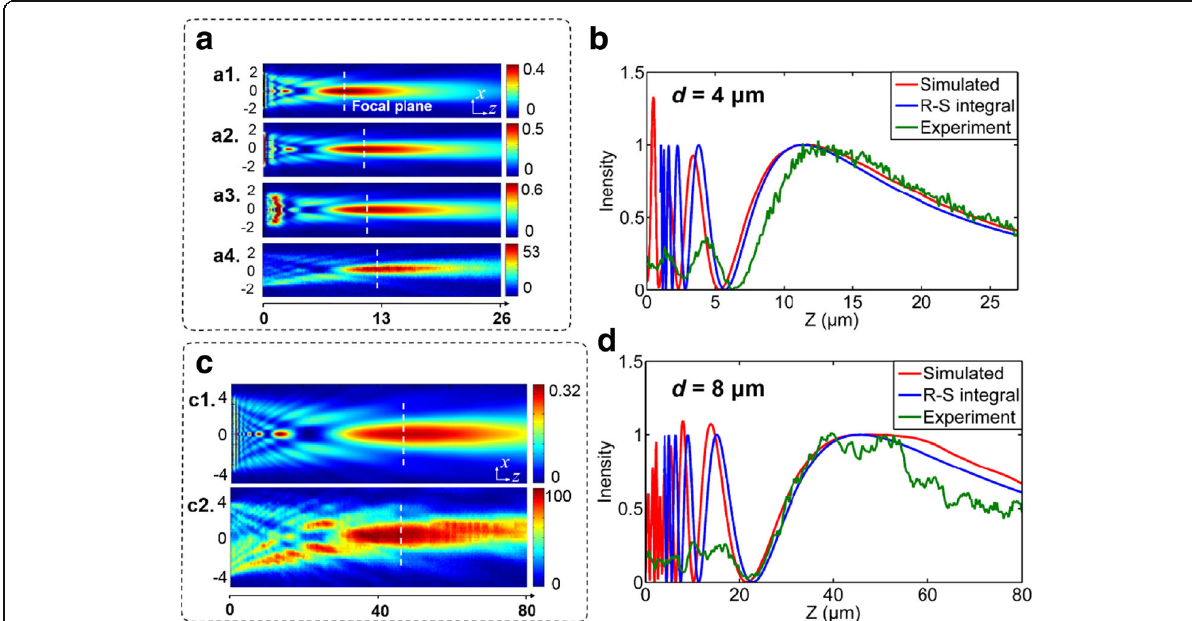
Fig. 5 a Optical field mappings of the 4 μ m microlens for the simulated cases of a1 λ = 633 nm, P = 522 nm; a2 λ = 532 nm, P = 522 nm; a3 λ = 532 nm, P = 900 nm; and a4 the measured result of λ =532 nm, P =900 nm. b The axial light intensity of the calculated R-S integral, FDTD simulation, and optical measurement for the designed microlens of d = 4 μ m. c The field intensity difference for the c1 simulated and c2 measured results when d = 8 μ m at λ = 532 nm, P = 900 nm. d The axial intensity for the microlens of d = 8 μ m. The intensity fields along the y-z planes are identically distributed as x-z planes